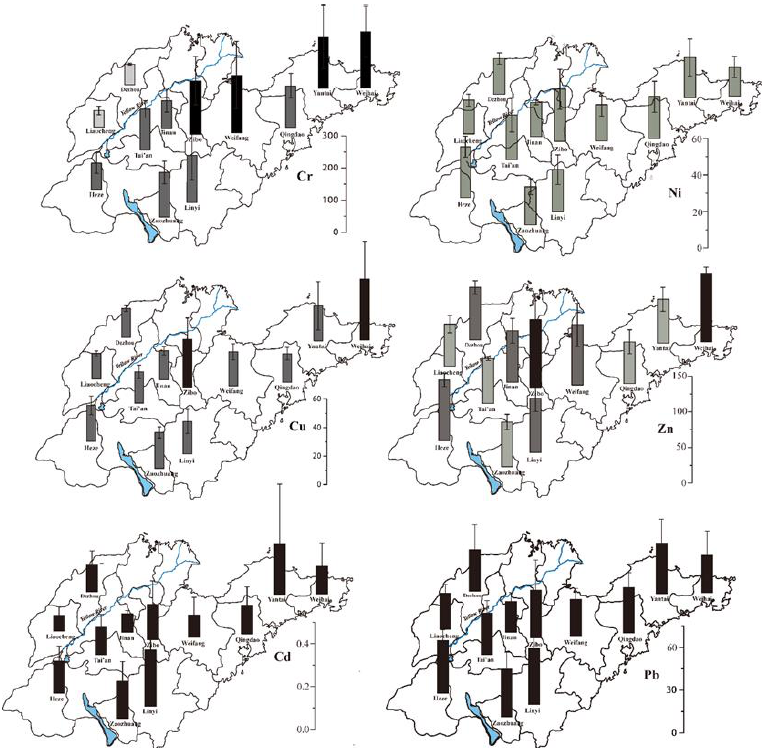
Figure 2. The spatial distribution patterns and concentrations of heavy metals in cropland soils of the cities in Shandong Province. Bars sharing the same color of each metal are not significant at α = 0.05 (Duncan test).